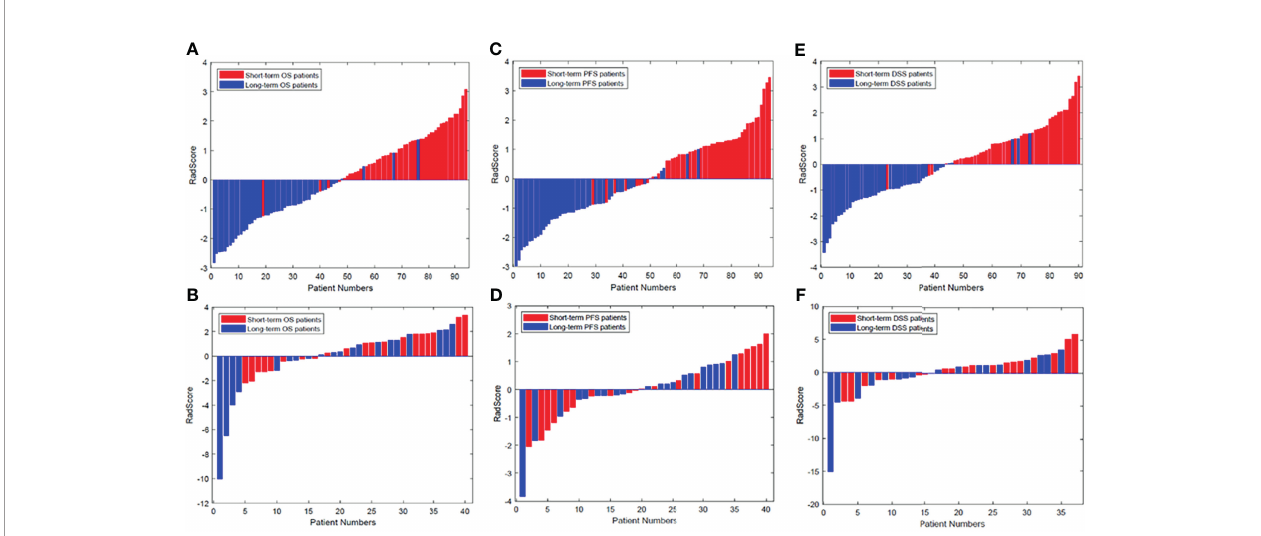
FIGURE 3 | Radiomics signature for each patient in the (A, C, E) training cohort and (B, D, F) validation cohort. The red bars show the radiomics signature values for the patients with short-term survival (OS, PFS, DFS), and the blue bars show the values for those with long-term survival. DSS, disease-speci fi c survival; OS, overall survival; PFS, progression-free survival.